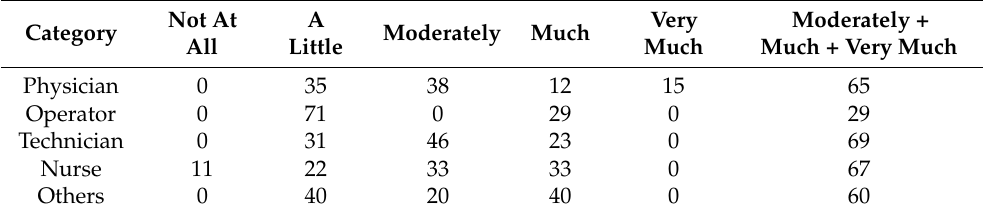
Table 6. Percentage of responses to the question: “How much does the noise affect your concentration?”.